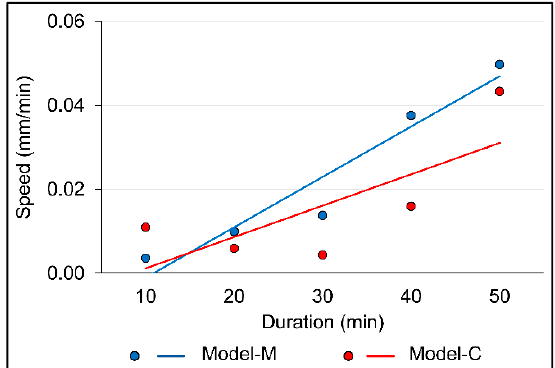
Figure 6. Average movement speed of the center of gravity.